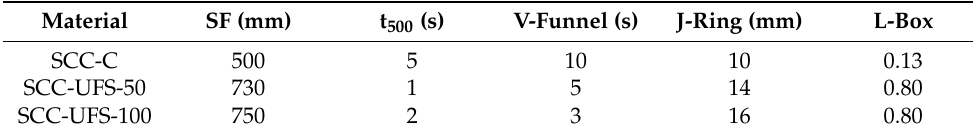
Table 5. Fresh state properties of the self-compacting